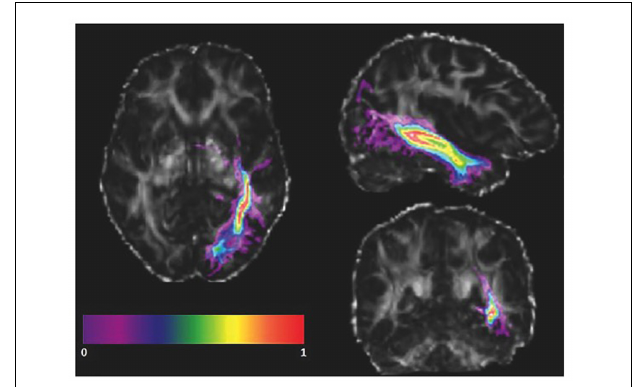
FIGURE 3 | Registered atlas-based ILF mask of a single subject. The probabilistic left ILF mask obtained from the JHU atlas (color) is co-registered with a subject’s FA map in standard space in radiological orientation. The masked brain areas were included in the weighted mean FA